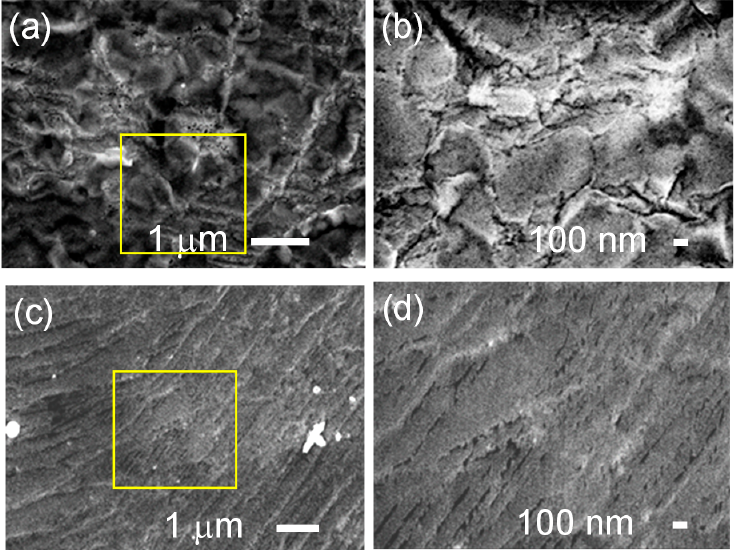
Figure 2. SEM images of 10-nm thick alumina ( a , b ) and 10-nm thick hafnia ( c , d ) on graphene coated 25 microns thick Cu foil. The yellow marked area in (a,c) is magnified in (b,d).